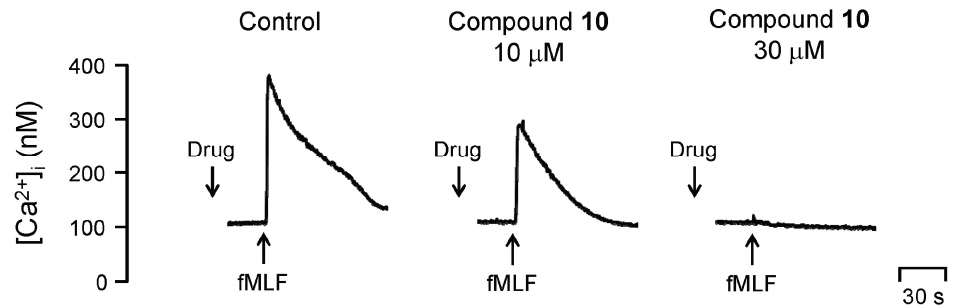
Figure 3. Compound 10 inhibits fMLF-induced [Ca 2+ ] i increase in human neutrophils. The traces shown are from three different